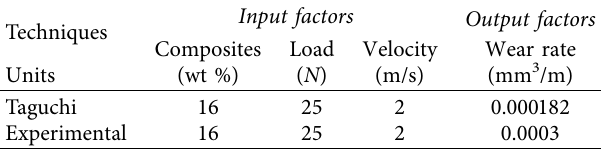
Table 8: Comparison of Taguchi and experimental techniques.